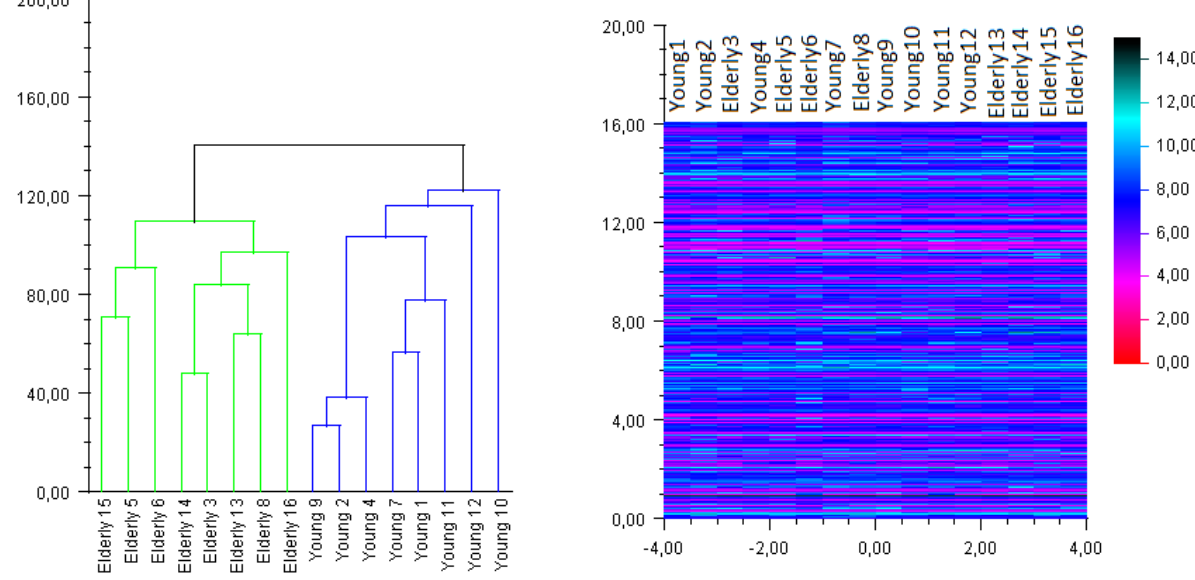
Figure 4: Resulting Dendogram and